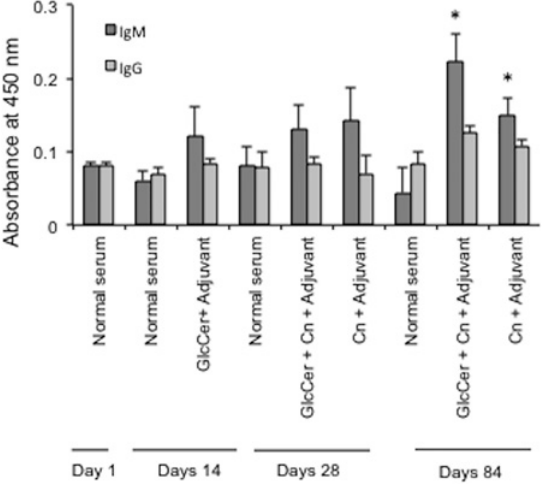
Fig 5. Detection of antibody against GlcCer in mice sera. IgM and IgG detection in the sera of CBA/J mice treated with weekly administration of 50 μ g GlcCer and complete Freund ’ s adjuvant (cFA) followed by iFA after a week. Plot shows the results of ELISA experiments performed using purified GlcCer as antigen. Data represents analysis from 3 independent experiments. * , P < 0.05, IgM GlcCer + Cn + Adjuvant at day 84 versus normal serum IgM at Day